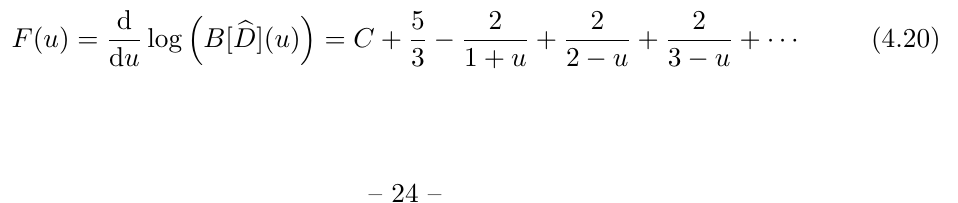
, with relative errors amounting to mere 10 ; 1 to c in that order. The 4 ; 1 10 ; 1